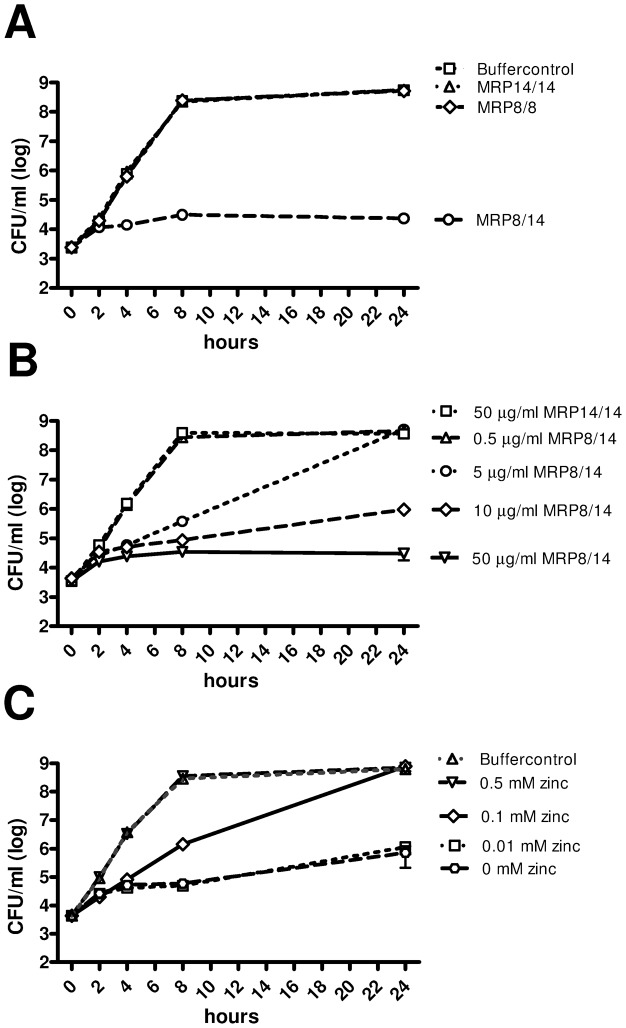
MRP8/14 reduces bacterial growth of K. pneumoniae through metal chelation.Growth of K. pneumoniae was assessed for a maximum of 24 hours in the presence of recombinant MRP8/14, MRP8 homodimer or MRP14 homodimer (50 µg/ml) (A). Bacterial growth was dose dependently inhibited by MRP8/14 (B); the growth inhibiting effect of MRP8/14 (10 µg/ml) was reversed by the addition of zinc (C). Data are means ± SEs of at least 3 replicates and representative of triplicate experiments.